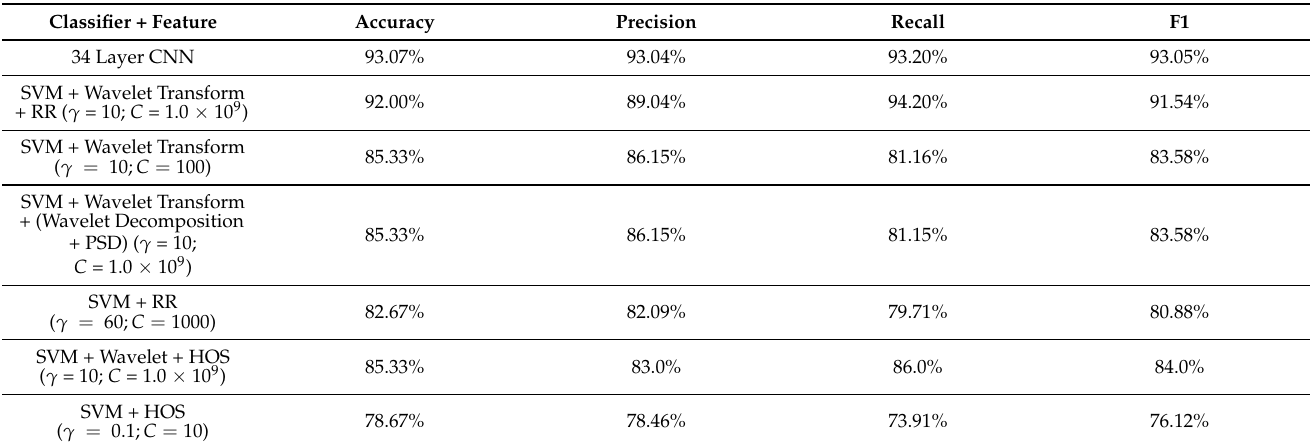
Table 5. Overview of the results from the CNN algorithm and SVM + handcrafted feature extraction methods.